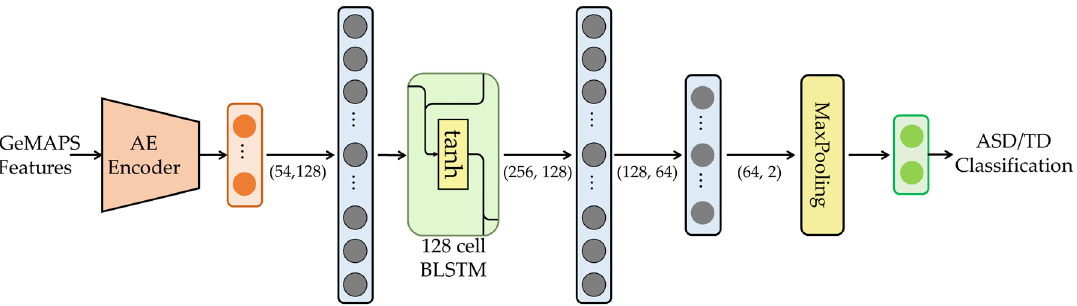
Figure 1. Network architecture for extracting bottleneck features using autoencoder with multi-task learning strategy.